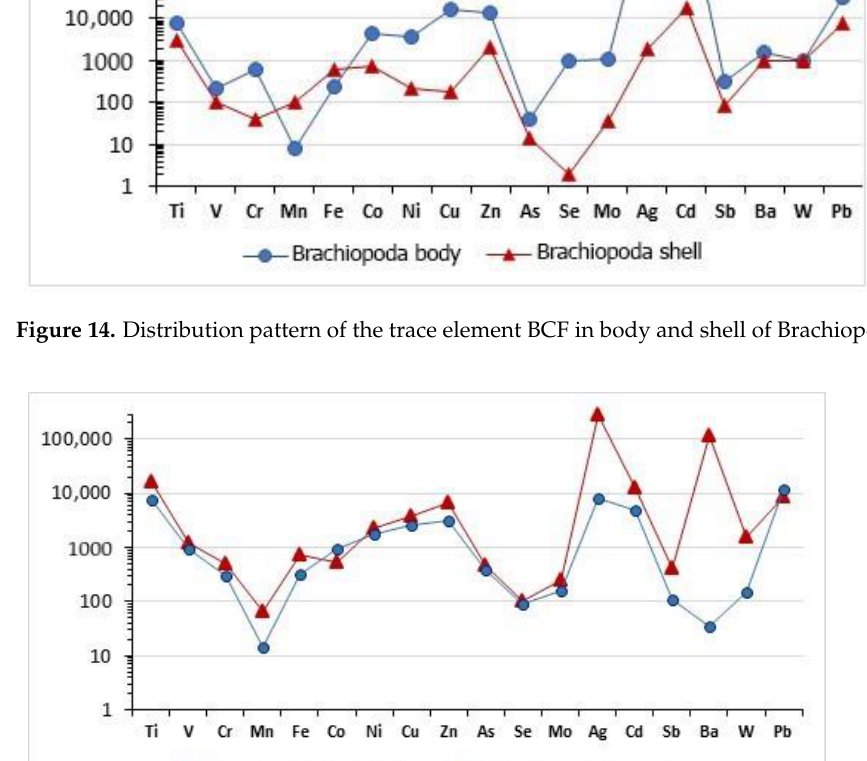
Figure 15. Distribution pattern of the trace element BCF in Zoantharia (Anthozoa).